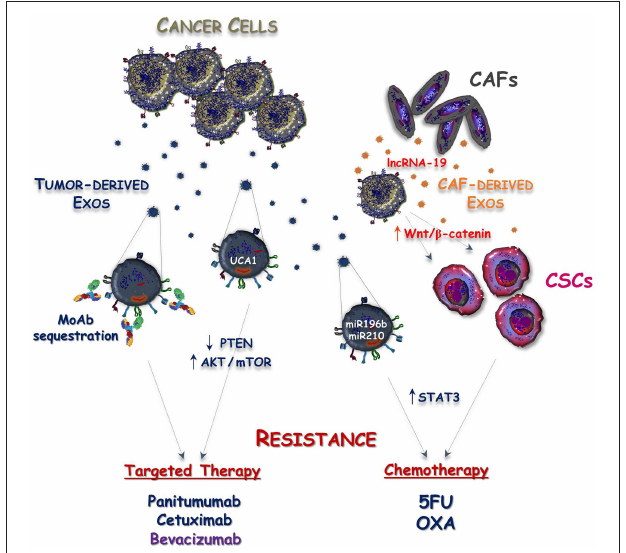
FIGURE 2 | Mechanisms responsible for Exosome-mediated drug resistance in CRC. Exosomes released by either tumor cells (Tumor-derived Exos) or cancer associated fibroblasts (CAF-derived Exos) cooperate to induce resistance of CRC against targeted and cytotoxic drugs. This process is mediated by exosomal delivery of non-coding RNAs into cancer cells leading to the stimulation of mTOR and STAT3 intracellular signaling, as well as to the acquisition of cancer stemness features. Additionally, sequestration of anti-EGFR (panitumumab and cetuximab) and anti-VEGF (bevacizumab) monoclonal antibodies (MoAbs) by Tumor-derived Exos is another possible mechanism reducing the bioavailability of these drugs and defective anti-cancer